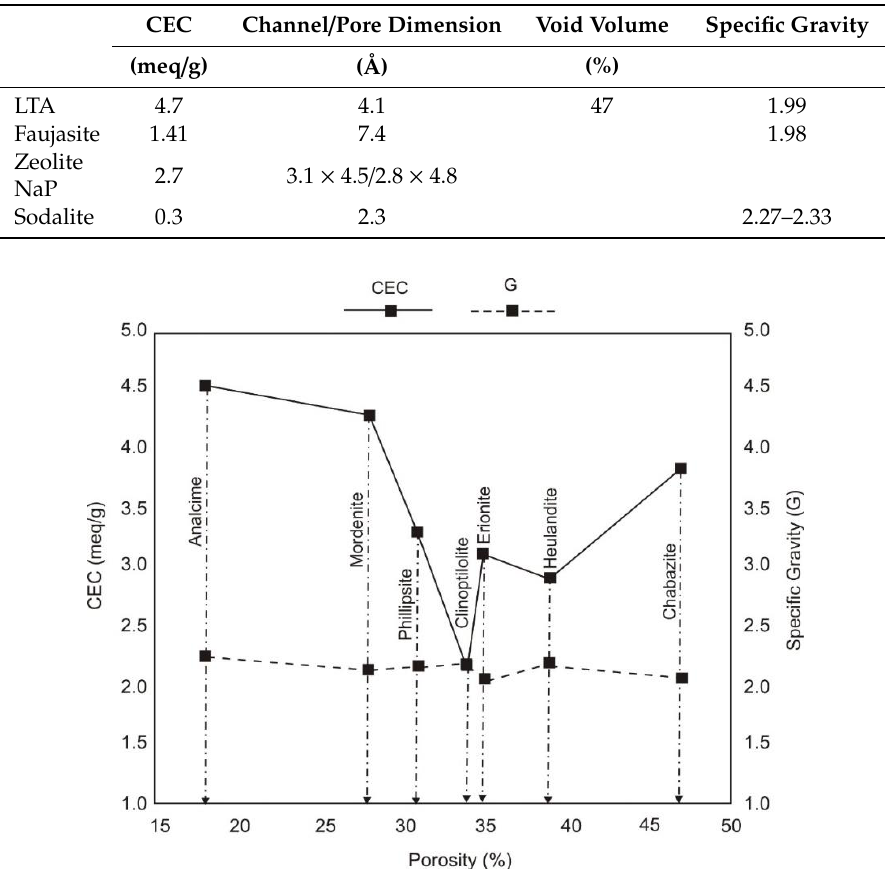
Figure 4. Cation exchange capacity (CEC) and specific gravity (G) variation with porosity of most common natural zeolites (adapted from [61]).